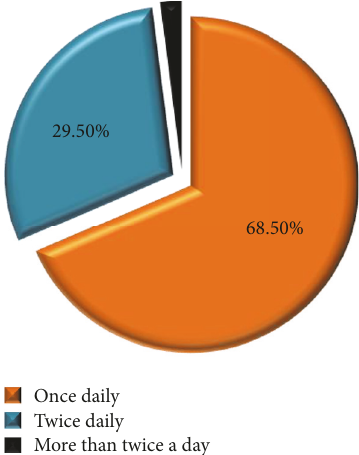
Figure 3: Frequency of brushing among study subjects.